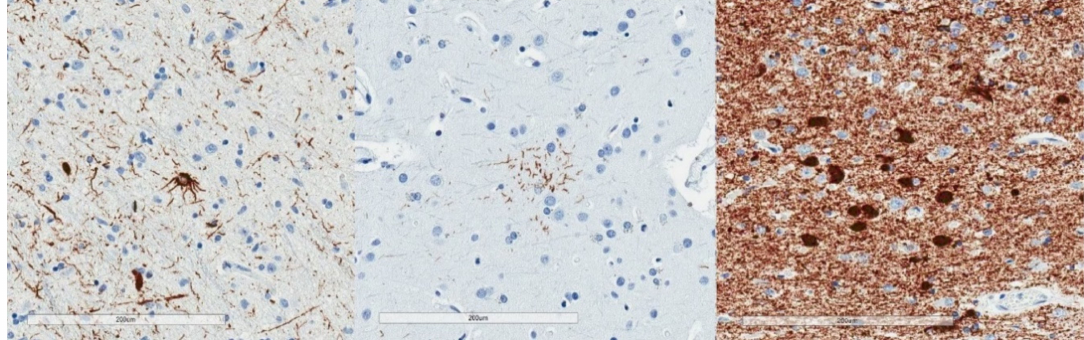
Figure 2. P-tau (AT8) immunohistochemical stains demonstrate a tufted astrocyte ( left ), an astrocytic plaque (middle), and Pick bodies ( right ). These morphologies are reasonably specific for progressive supranuclear palsy, corticobasal degeneration, and Pick disease,